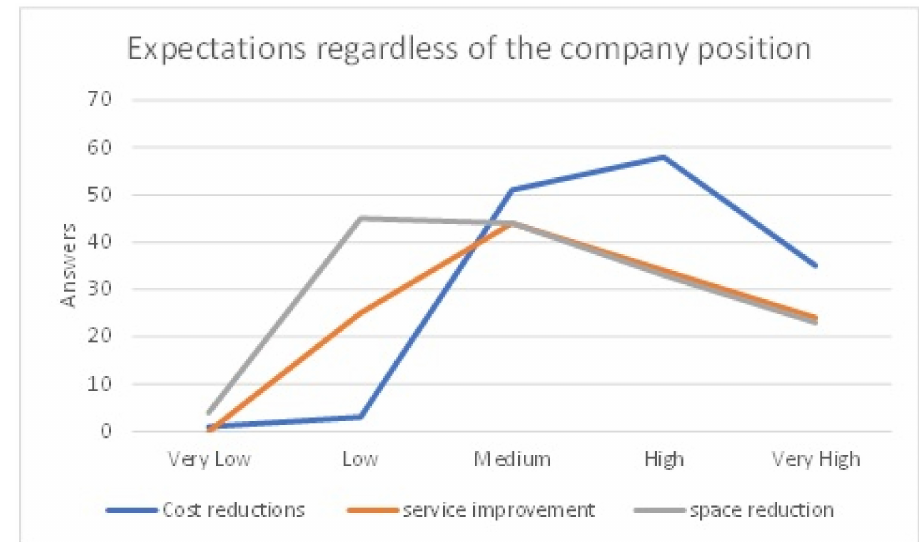
Figure 5. Expectations from the participants regardless of the company position.